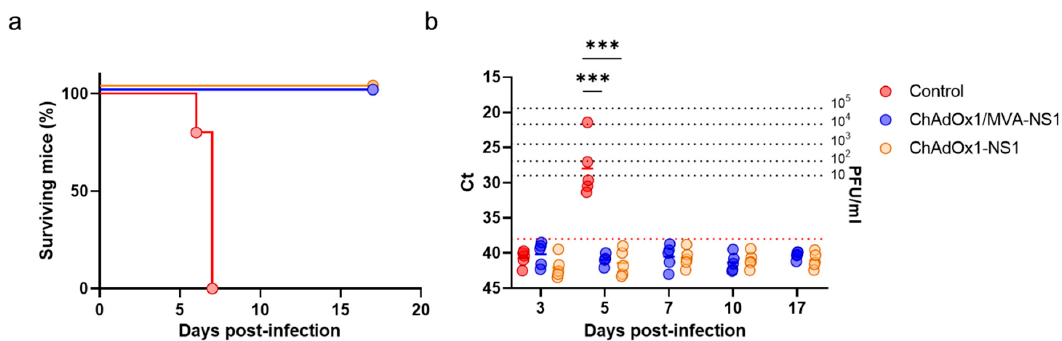
Figure 4. Protection of immunized IFNAR(- / -) mice against a lethal challenge with BTV-8. Groups of mice ( n = 5) were immunized with a single dose of 10 8 IU per mouse of ChAdOx1-NS1 or following a heterologous prime-boost regimen consisting of an initial dose of 10 8 IU per mouse of ChAdOx1-NS1 (prime) followed by a second dose of 10 7 PFU per mouse of MVA-NS1 (boost), administered 28 days apart. Immunized and non-immunized mice were challenged with a lethal dose (10 PFU) of BTV-8 at day 30 post-immunization (prime-only) or at day 15 post-boost (prime-boost). ( a ) Survival rates after infection. Statistical di ff erences between the curves were calculated using Log-rank test. ( b ) Detection of BTV-4M in blood of non-immunized and immunized IFNAR(- / -) mice after challenge by RT-qPCR. Expression of mRNA of segment 5 (encoding NS1 protein) was quantified at 3, 5, 7, 10 and 17 d.p.i. Results are expressed as Ct (left y-axis) and PFU equivalents (right y -axis and dotted horizontal lines). Cut-o ff Ct ≥ 38 (dotted pink line). Di ff erences between groups were calculated by multiple t test analysis using the Sidak–Bonferroni method. *** p -value < 0.001.